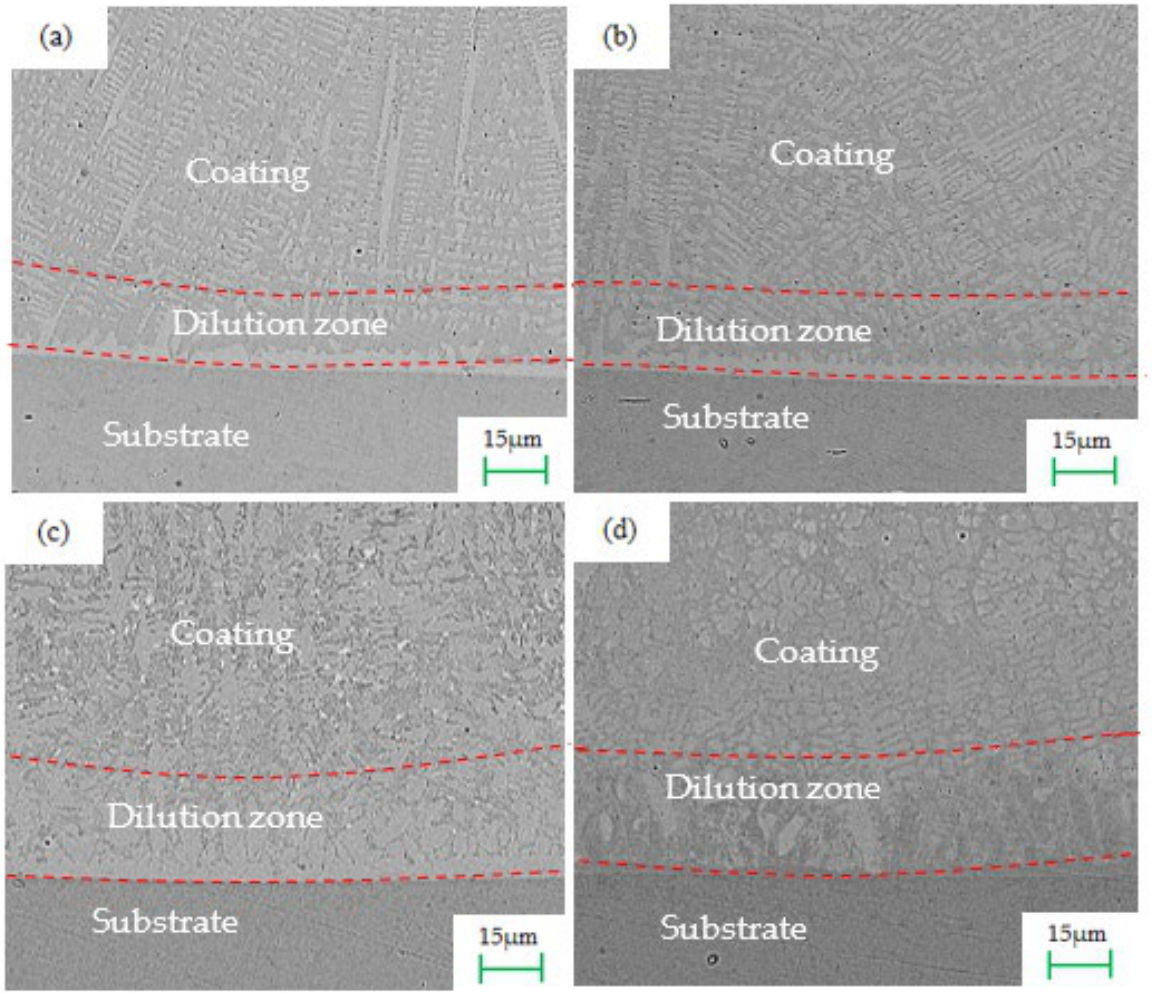
Figure 5. Micrographs at the junction between the coatings and substrate on the cross section. ( a ) CoCrNi, ( b ) CoCrNiMo 1 , ( c ) CoCrNiMo 3 , and ( d ) CoCrNiMo 5.